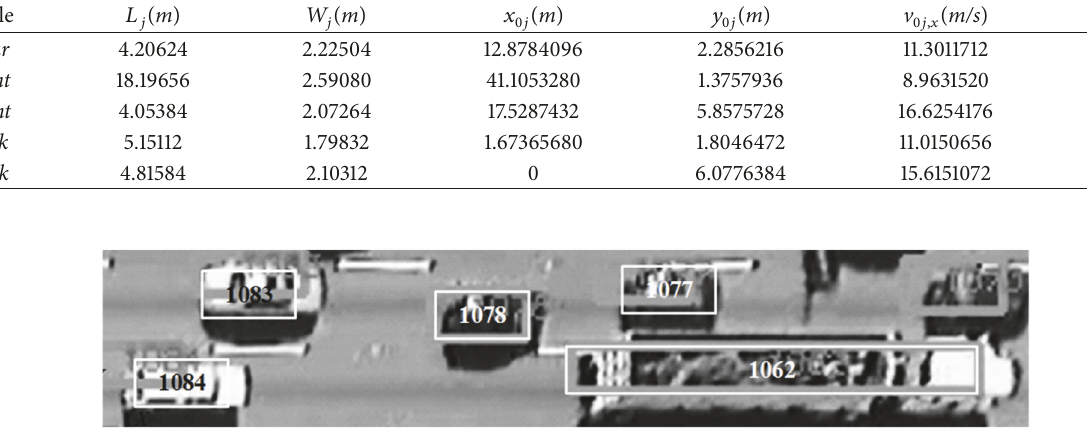
Figure 14: Data extraction scene.